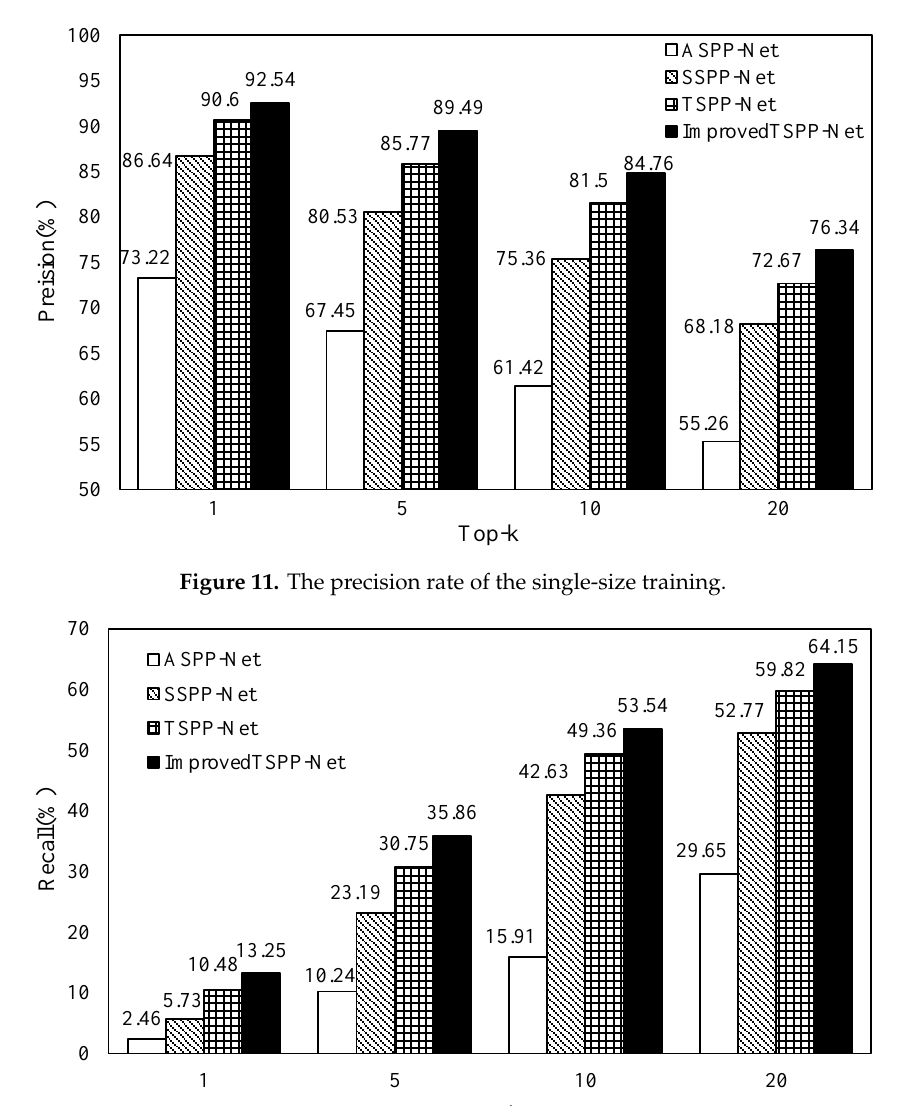
Figure 12. The recall rate of the single-size training.